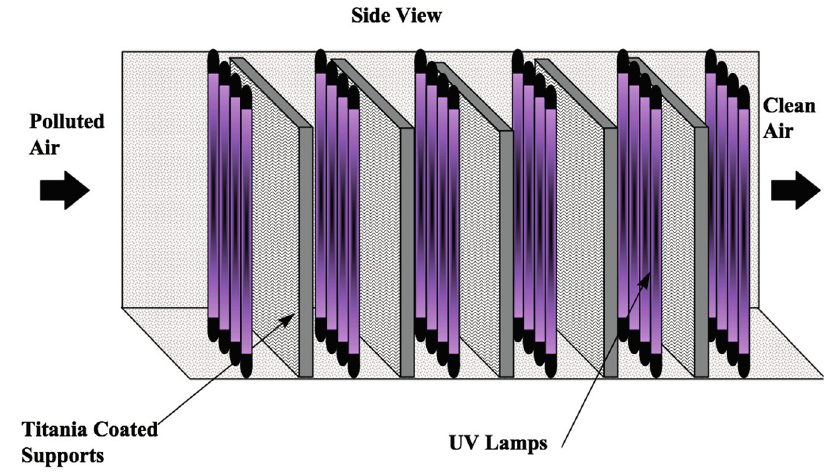
Figure 1. Generic Multi-stage, Honeycomb-Monolith Photocatalytic